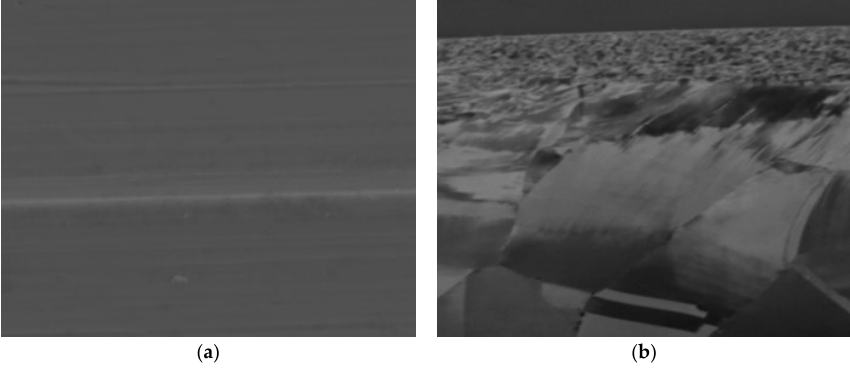
Figure 13. ( a ) Top down and ( b ) cross sectional SEM images of Inconel 625 sample surface, prior to test (5000 × ).